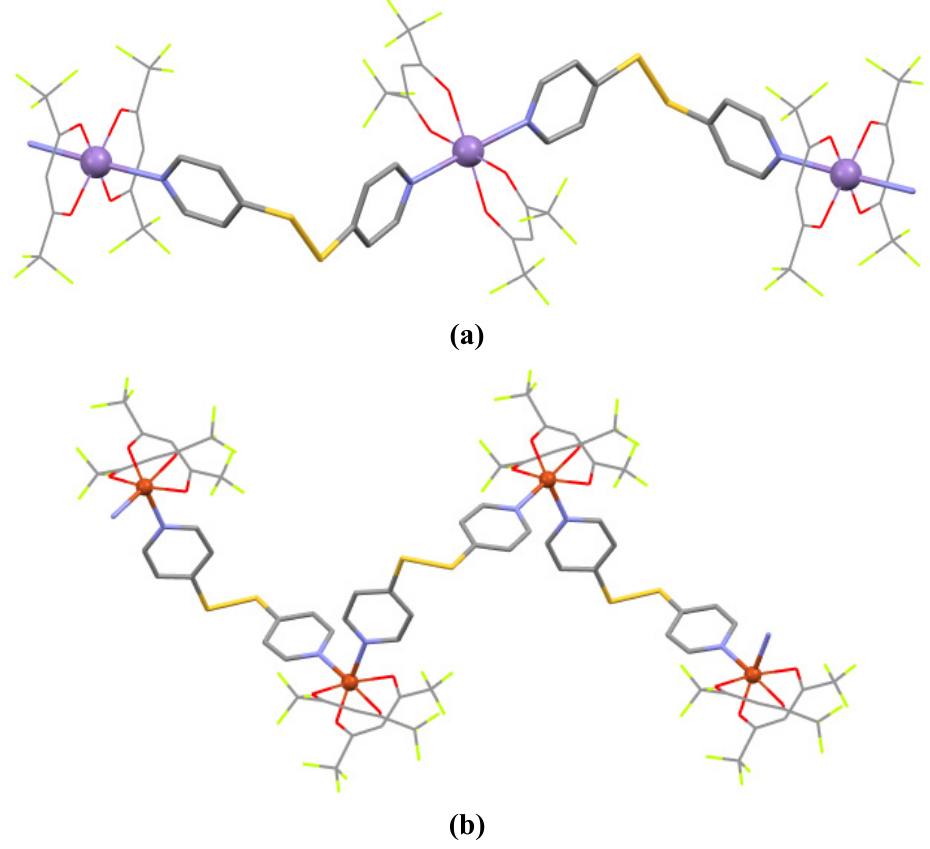
H O PS ) ( μ - dtdp )] 8 10 2 2 2